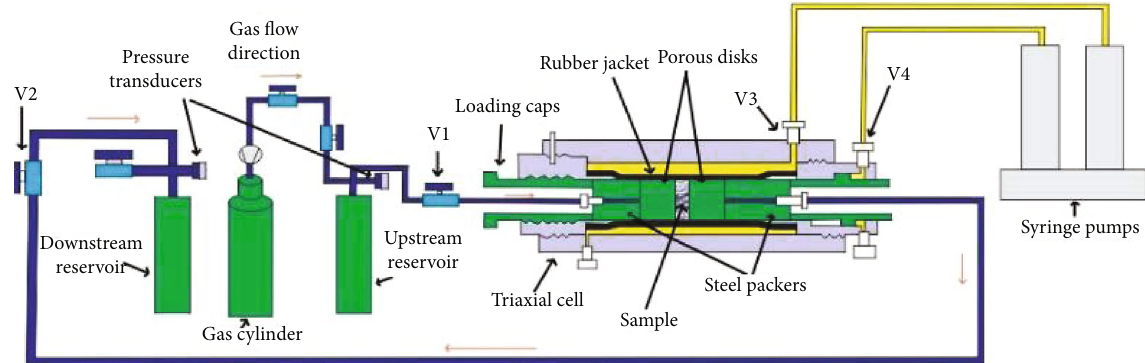
Figure 5: Schematic view of the pulse-decay experimental setup for the permeability evolution test. V1 is the valve controlling inlet gas fl ow from upstream, V2 is the valve controlling outlet gas fl ow to downstream, and V3/V4 is the valve controlling the con fi ning/axial pressure applied on the